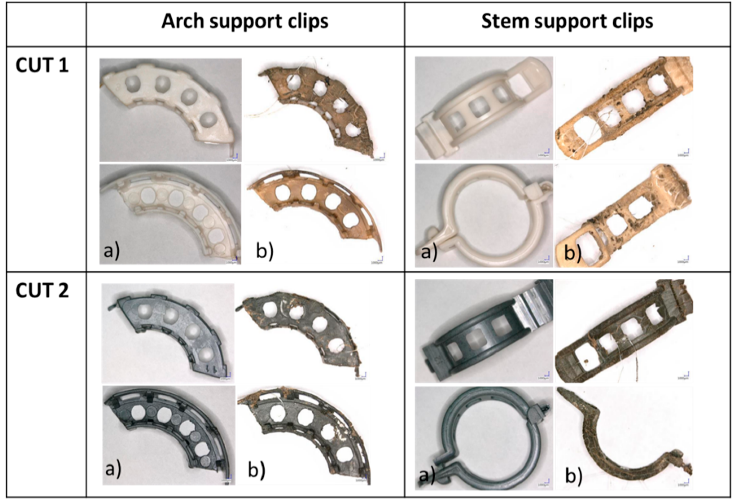
Figure 7. CUT 1 and CUT 2 arch and stem support clips prior to ( a ) and after the 16 week laboratory ( b ) composting (magnitude ×10).